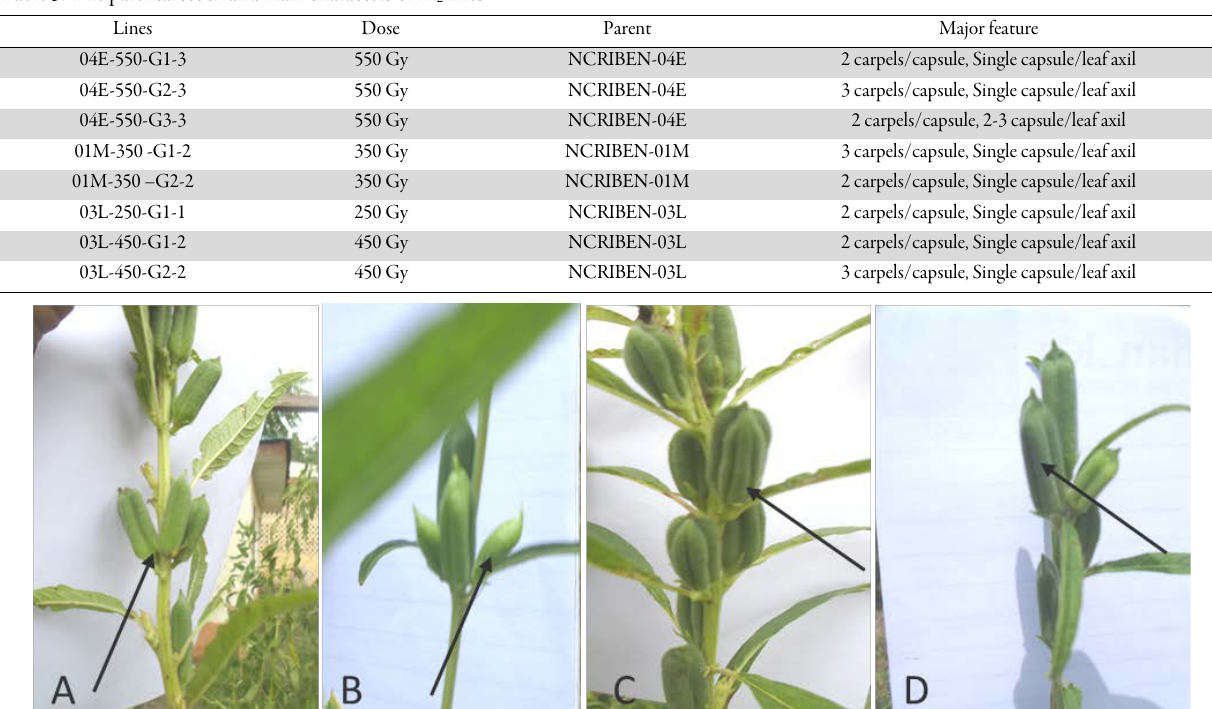
Table 3. The parental stock and main characters of M 2 lines